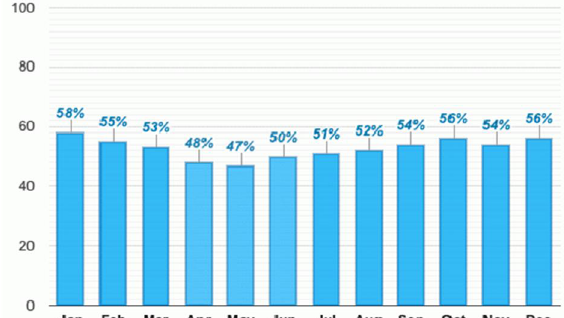
Figure 6. The average monthly RH, in Dubai, UAE. Graph generated by the author from reference [42].